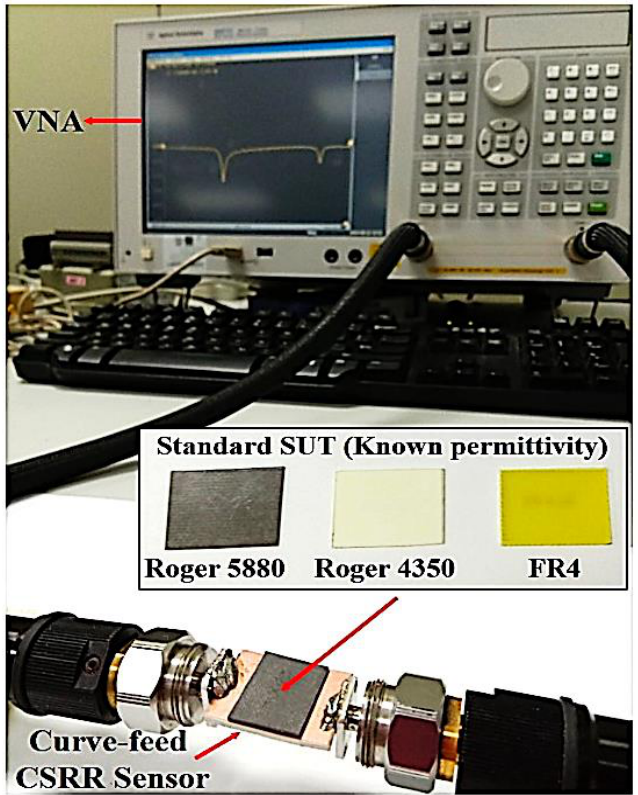
Figure 14. The SUTs prototypes validation for the curve-feed CSRR sensor. Table 5. Frequency change with various dielectric of solid